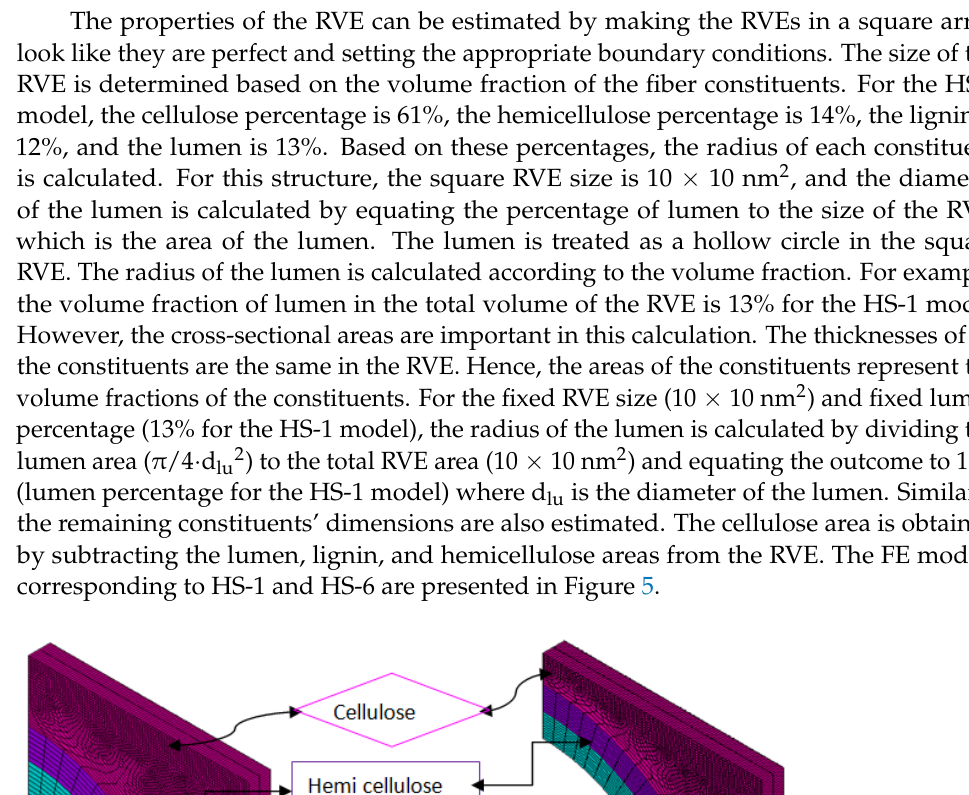
Table 4. Geometrical details of the Hierarchical Structure for FE Models.